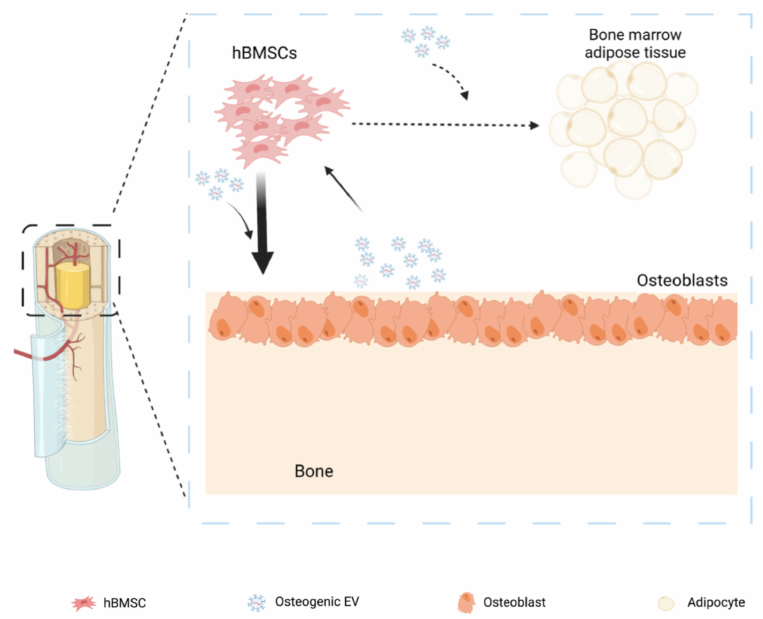
Figure 9. Summary Osteogenic primed EVs positively regulate osteogenic differentiation and neg- atively regulate adipogenic differentiation capacity of naïve hBMSCs. Finally, bone loss and reduced bone formation is accompanied by increased marrow adiposity in osteoporosis. This is a major clinical sequela for patients with malignant dis- eases (e.g., lymphoma, leukaemia) undergoing chemotherapy, radiation therapy or recov- ering from osteoporotic fractures [54]. Therefore, if an agent or drug could alter the cellu- lar lineage allocation early in the pathologic bone marrow to favor osteogenesis and sup- press adipogenesis from precursor MSC [55], this could have a major inhibiting effect on osteoporosis morbidity and tremendous cost savings.